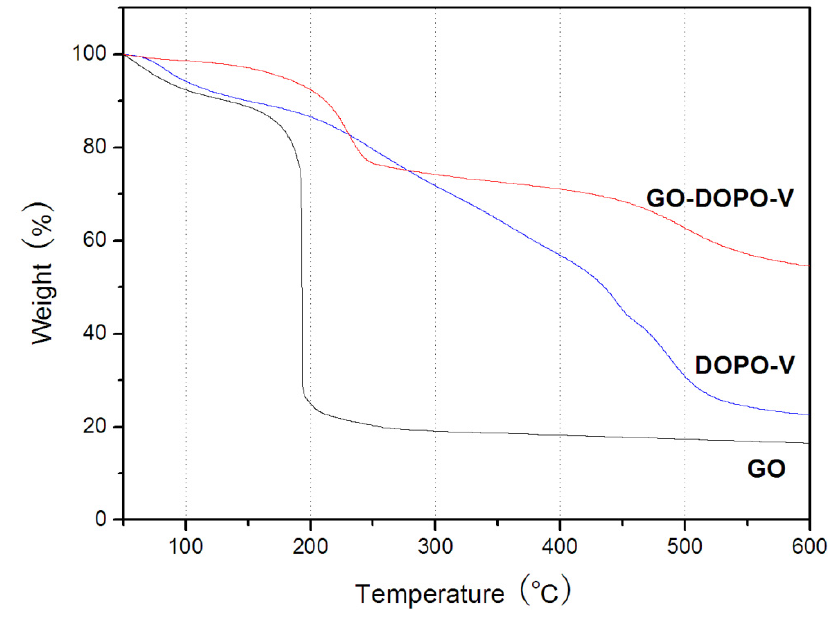
Figure 6. TGA curves of GO, DOPO-V and GO-DOPO-V.